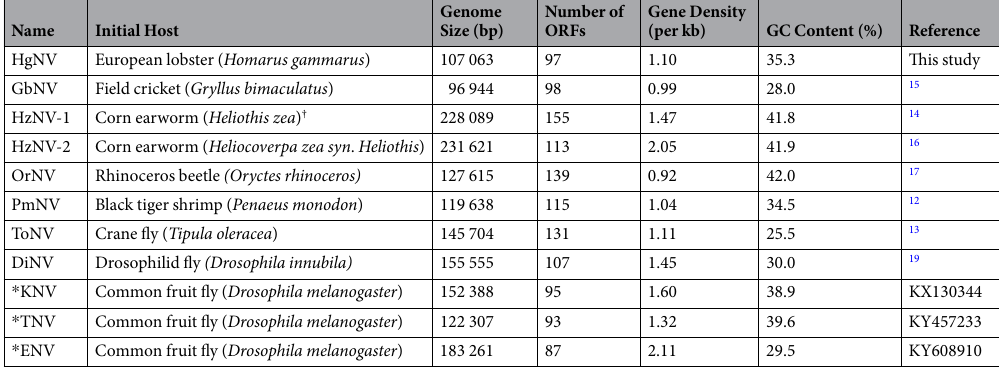
Table 1. Comparative genomic data of sequenced nudiviruses. † Cell line. * Direct submission to GenBank - number of ORFs, gene density and GC content estimated from database entry. Accession numbers provided where journal reference of genome annotation is not